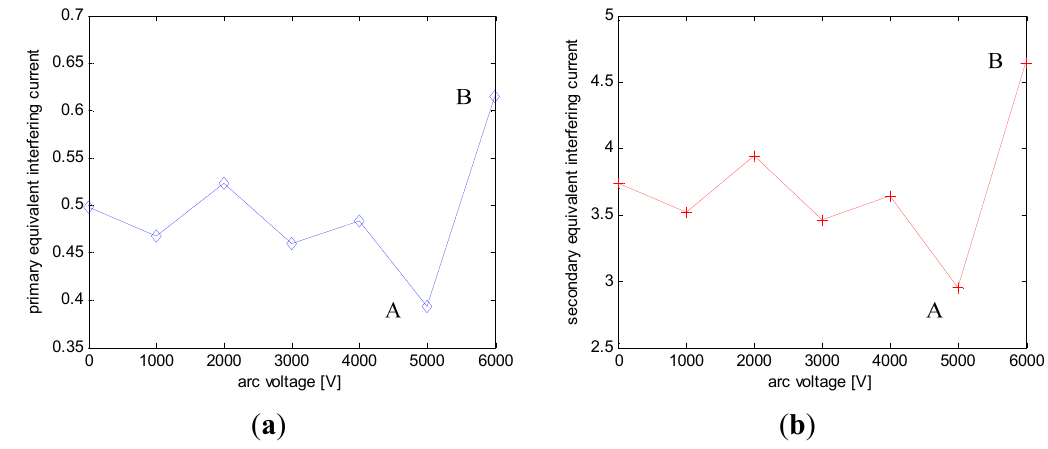
Figure 11. ( a ) Primary equivalent interfering current and ( b ) Secondary equivalent interfering current.